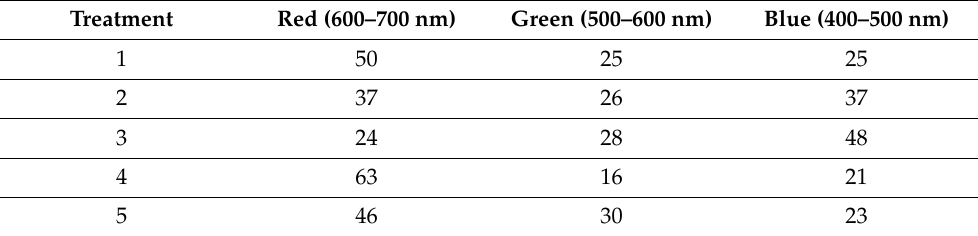
Table 2. Color breakdown for light treatment spectra as a percentage of total photosynthetic photon flux density (PPFD).